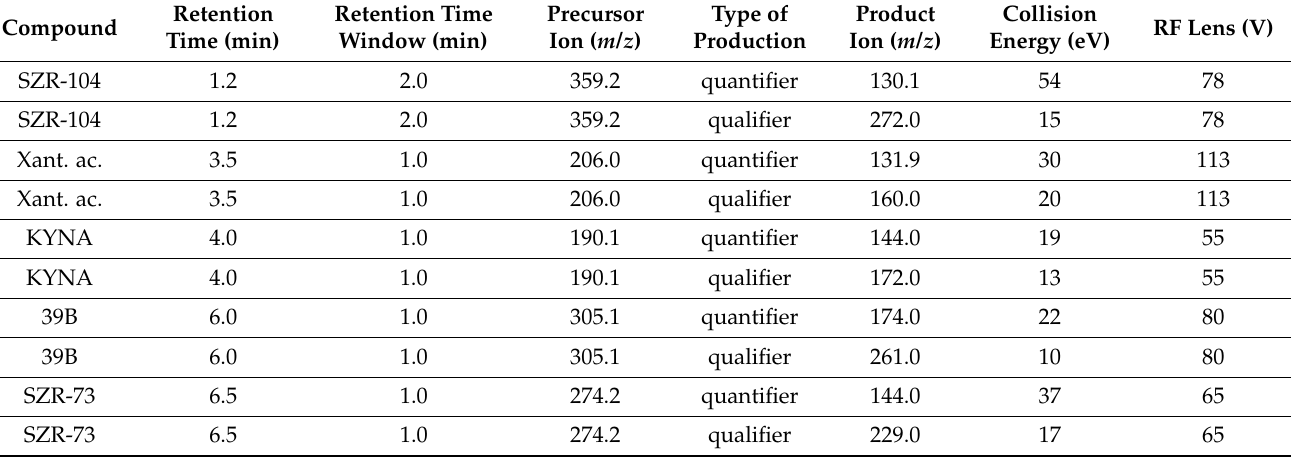
UHPLC-MS/MS parameters for selected reaction monitoring transitions in positive mode.Xant. ac = xanthurenic